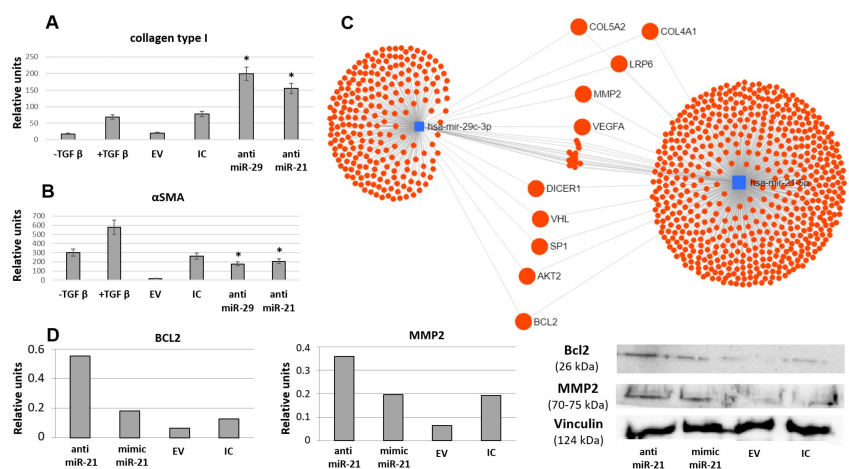
Figure 11. Inhibition of selected microRNAs (miR-21 and miR-29c) by antagomiRs attenuates EV-mediated MSC ability to prevent TGFbeta-induced di ff erentiation of fibroblasts into myofibroblasts evaluated by collagen type I production ( A ) and aSMA expression ( B ), Western blotting ( n = 3). EV: MSC-EV without transfection, IC: MSC-EV transfected by inhibitory control oligos (control for anti-miRs). anti-miR-21: MSC-EV transfected by anti-miR-21, anti-miR-29: MSC-EV transfected by anti-miR-29 * p < 0.05 (compared to control groups). ( C ) Common targets of miR-21 and miR-29c predicted using MirNet service. ( D ) Impact of miR-21 transferred by MSC-EV into the regulation of selected pro-fibrotic targets in fibroblasts evaluated by Western blotting ( n =